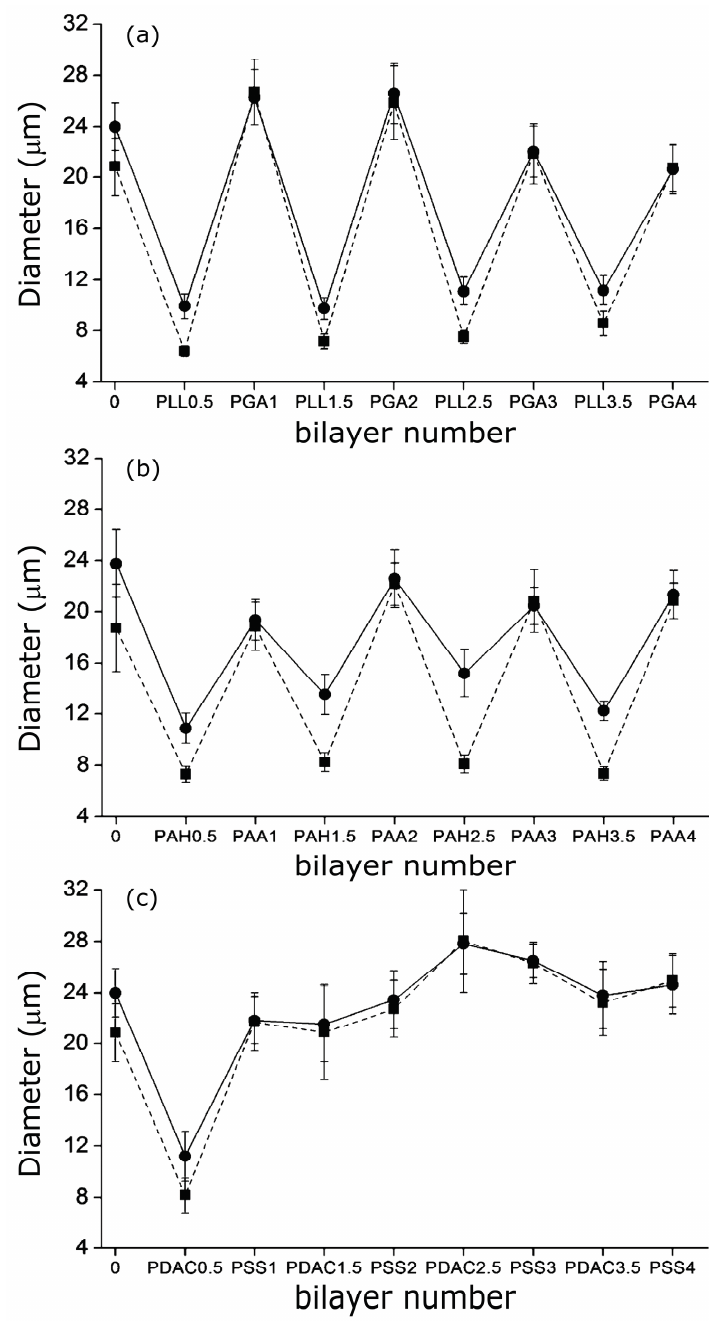
Figure 9. Hydrodynamic diameter of PNIPAM- co -MAA MGs upon LbL assembly of: ( a ) PLL/PGA; ( b ) PAH/PAA and ( c ) PDACMAC/PSS at 24 °C (circles) and 37 °C